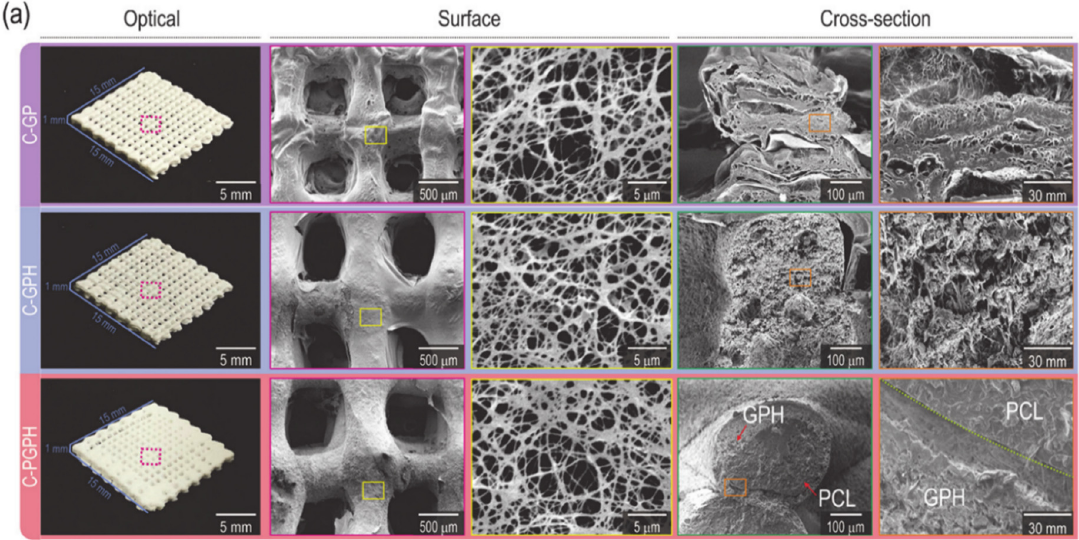
Figure 2. Optical and SEM images of C-GP, C-GPH, and C-PGPH scaffolds. Picture taken from Kim